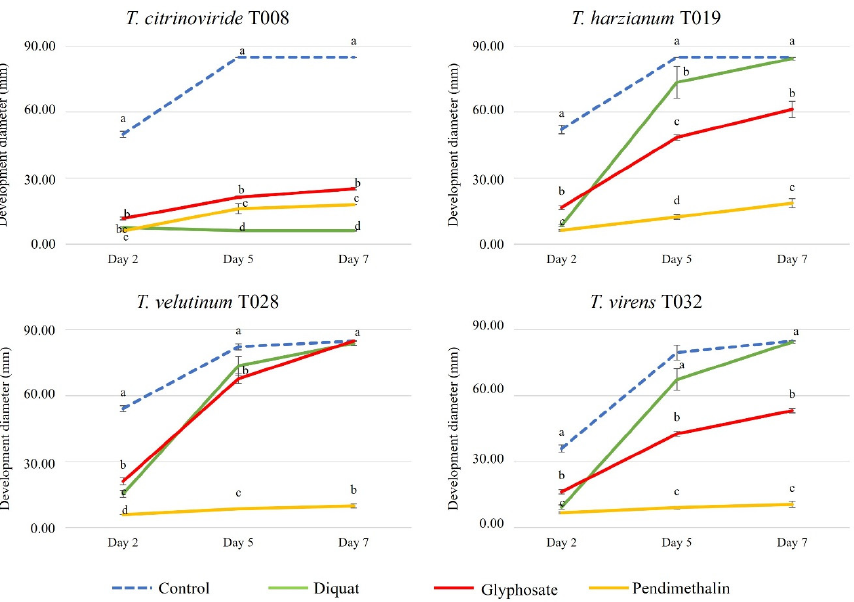
Figure 8. Development of autochthonous Trichoderma strains (diameter of growth, mm) in media with synthetic herbicides at 2, 5 and 7 days after inoculation. Blue color: control Petri dish. Green color: Diquat 20%. Red color: Glyphosate 36%. Yellow color: Pendimethalin 33%. The concentrations of each pesticide are specified in Table 2. Upper and lower error bars are represented and indicate standard error of the mean showing the accuracy of the calculations. Different letters indicate significant differences between synthetic herbicides (ANOVA, LSD, p < 0.05).